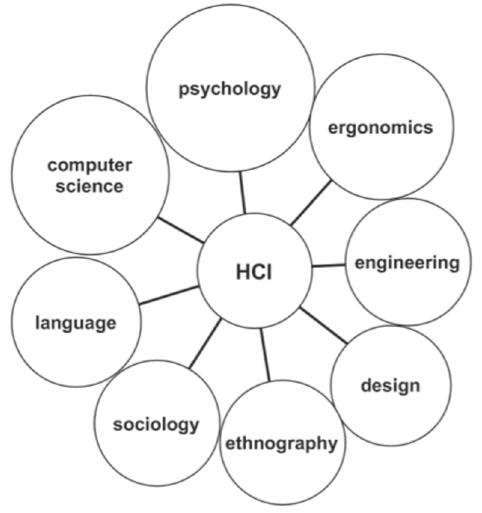
Figure 2. Human-computer-interaction depends on many disciplines.